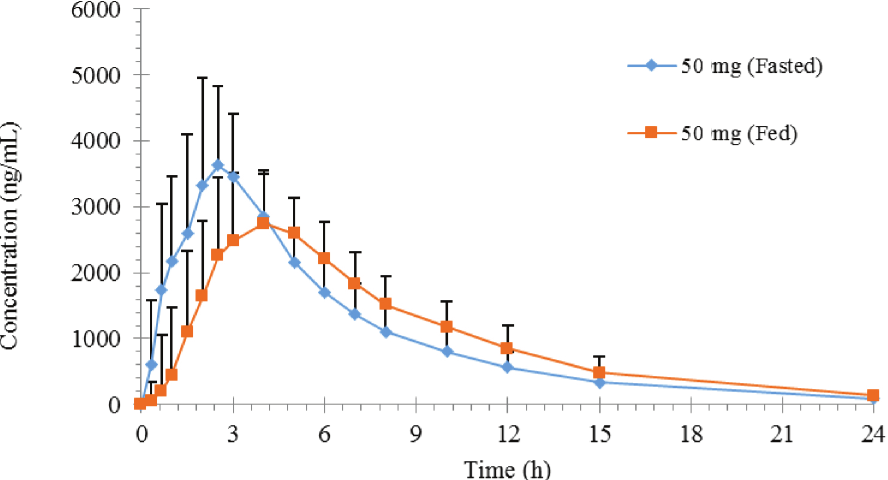
FIGURE 1 - Mean plasma concentration-time curves of rhein after oral administration of 50 mg dose of diacerein capsule (Artrodar ® ) in fed state or fasted state. Data are represented as mean ± standard error of the mean.